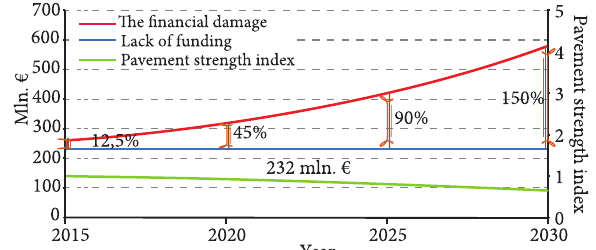
Fig. 5. Projected losses for 2015–2030 period